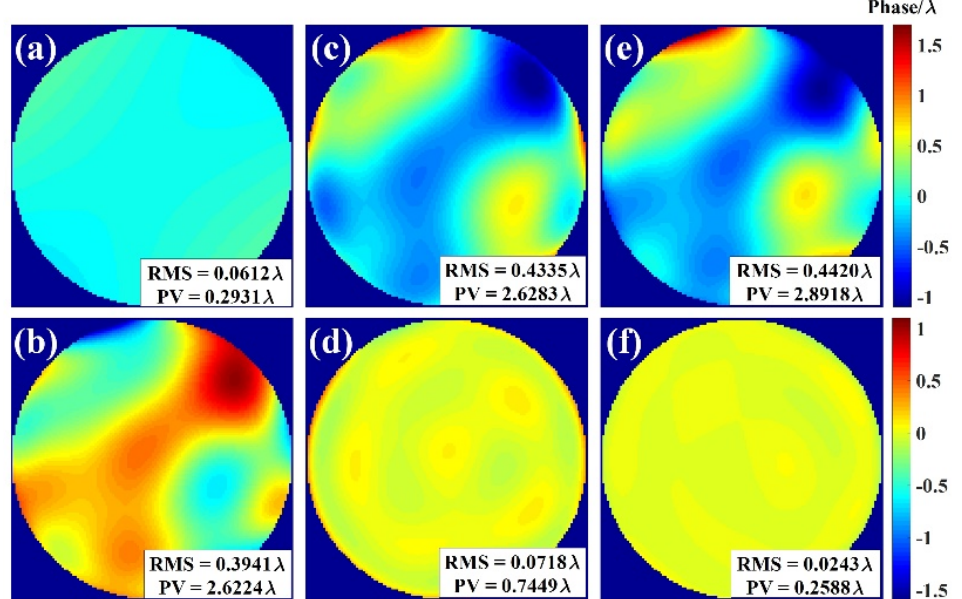
Figure 6. Reconstructed wavefront and residual wavefront by different methods. ( a , b ) Modal algorithm based on SHWFS. ( c , d ) SPGD algorithm based on SHWFS. ( e , f ) SPGD algorithm based on FBPM-SHWFS.